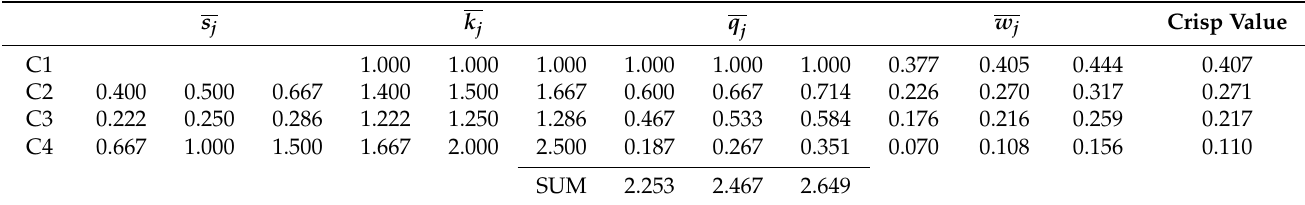
Table 3. Calculation process and weights of the main criteria applying fuzzy SWARA in [35]. s j k j q